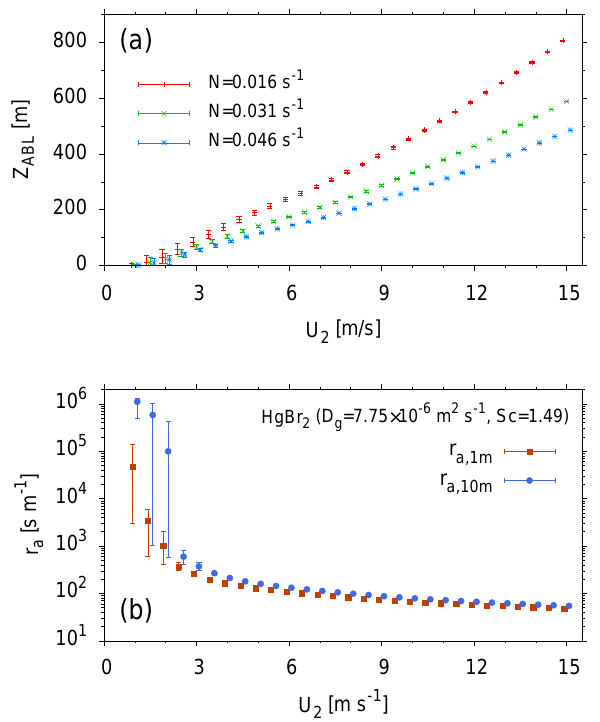
Fig. 2. (a) Changes in the diagnosed height of the turbulent atmo- spheric boundary layer ( Z ABL ) with surface wind speeds ( U 2 ) be- tween 1 and 15ms − 1 and Brunt–Väisälä frequencies in the free troposphere ( N ) between 0.016 and 0.046 s − 1 . Cross marks denote daily mean values while bars indicate the range of diurnal variations; (b) aerodynamic resistance for HgBr 2 from the snow surface to the height of either 1m or 10m in ambient air for U 2 = 1 − 15ms − 1 at N = 0 . 031s − 1 as calculated in the present model. Filled squares and circles denote daily mean values while bars indicate the range of diurnal variations.